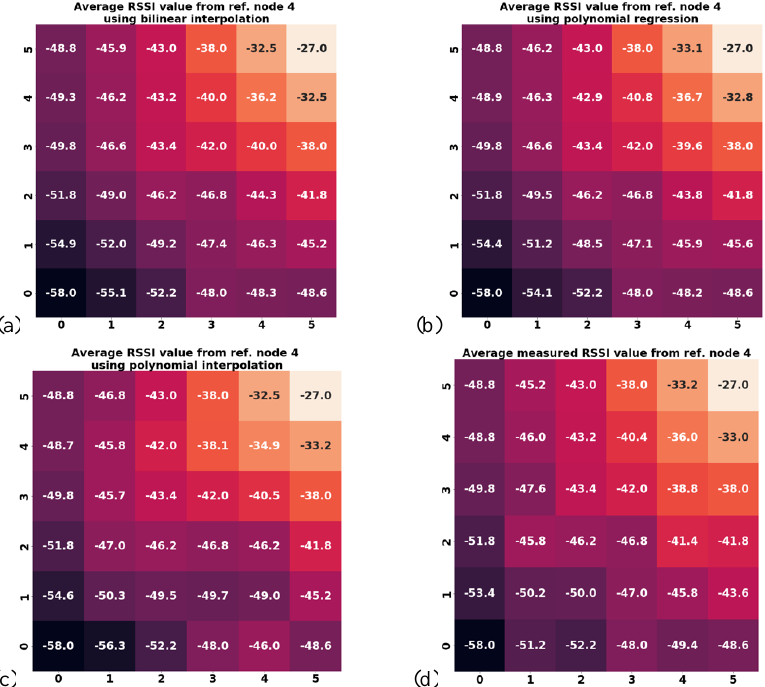
Figure 22. RSSI heatmap reference node 4. a) Bilinear inter., b) Polynomial reg., c) Polynomial inter., d) Measurement Localization Results